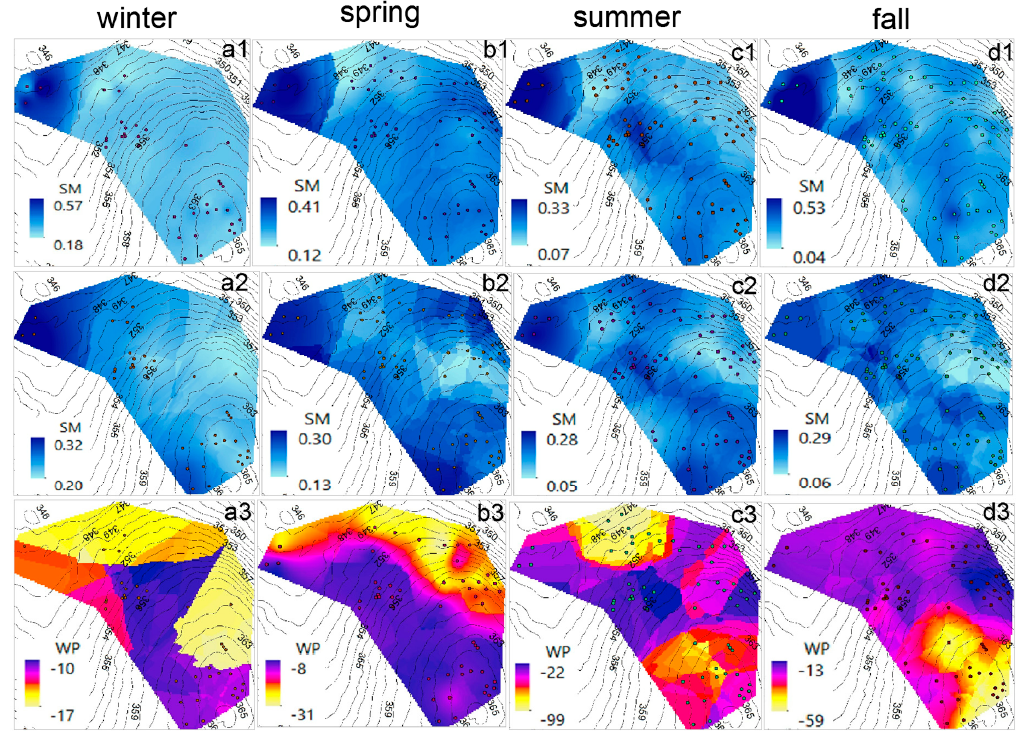
Figure 12. Interpolated surfaces (Kriging method) showing the average seasonal variation in volumetric soil moisture (SM) and soil water potential (WP), based on data retrieved from 2010 to 2016. ( a ) winter average (December–February): ( a1 ) SM at 10 cm; ( a2 ) SM at 30 cm; ( a3 ) WP at 30 cm; ( b ) spring average (March–May): ( b1 ) SM at 10 cm; ( b2 ) SM at 30 cm; ( b3 ) WP at 30 cm; ( c ) summer average (June–August): ( c1 ) SM at 10 cm; ( c2 ) SM at 30 cm; ( c3 ) WP at 30 cm; ( d ) fall average (September–November): ( d1 ) SM at 10 cm; ( d2 ) SM at 30 cm; ( d3 ) WP at 30 cm. SM is expressed in m 3 · m − 3 . WP is expressed in kPa. The elevation contours are expressed in m. The dots represent the nodes from which the data was